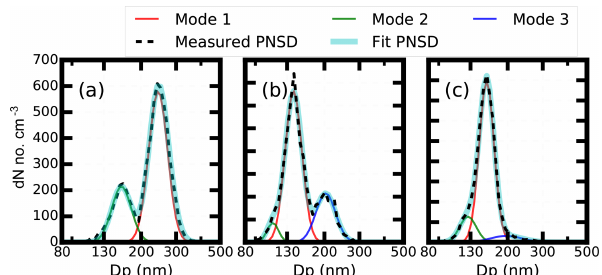
Figure 3. The measured aerosol PNSD (black dotted line), fit aerosol number PNSD (blue solid line) and fit aerosol PNSD at three different modes in different colors that passed through the CPMA. (a–c) The aerosol mass concentrations of 12, 1 and 1.45fg, respec- tively.